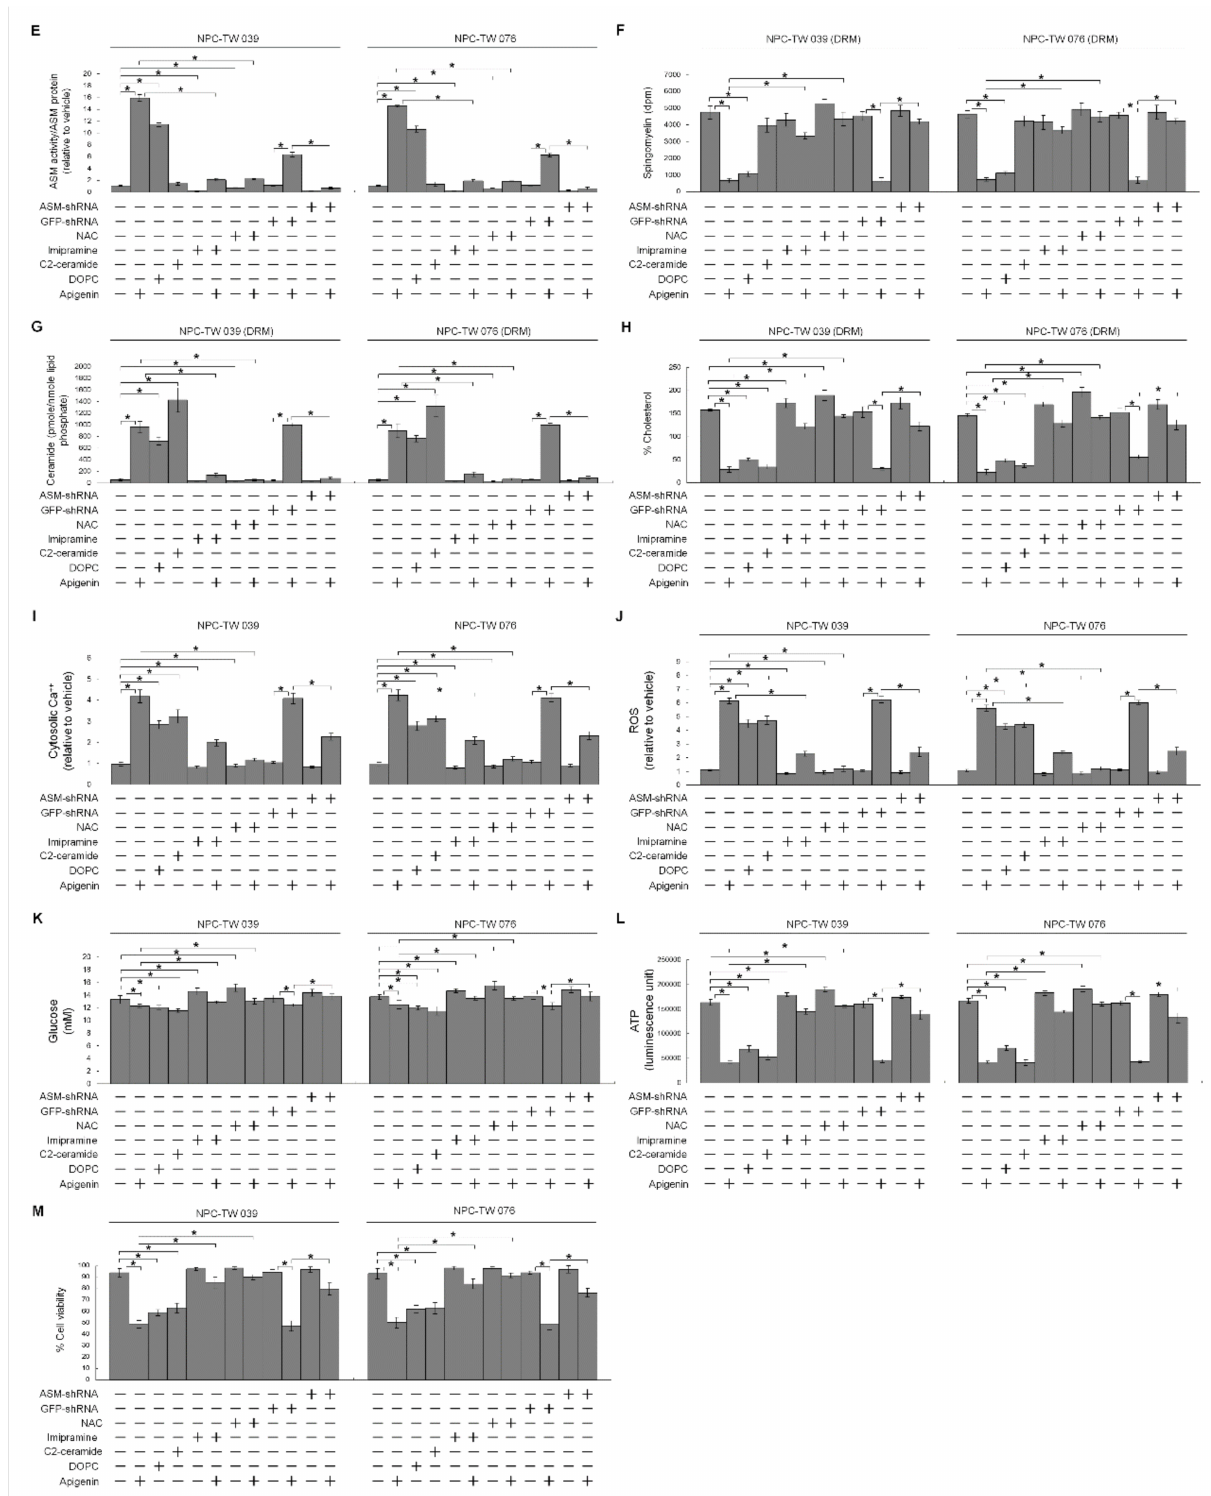
Figure 6. Apigenin-induced oxidative stress-dependent lipid raft-associated acid sphingomyelinase (ASM) activity causes dysregulation of the endoplasmic reticulum (ER)/mitochondria bioenergetic and lipid metabolism. ( A , B , E – M ) At 12 h after transfection with an empty vector, GFP shRNA or ASM shRNA cells were treated with either vehicle ( − ), apigenin (35 µ M), 1,2-dioleoyl- sn -glycero-3-phosphocholine (DOPC) (15 nmole), C2-ceramide (6 µ M), imipramine (5 µ M), apigenin (35 µ M) plus imipramine (5 µ M), N-acetyl-L-cysteine (NAC) (100 µ M), or apigenin (35 µ M) and NAC (100 µ M) for 36 h. The levels of the indicated proteins in the cell lysates were determined by Western blot analysis with specific antibodies. β -Actin